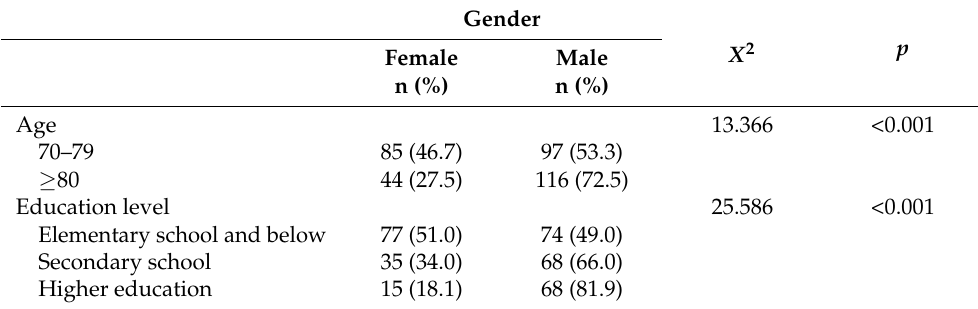
Table 3. Differences in male-to-female ratios by age stratification and educational level (N =